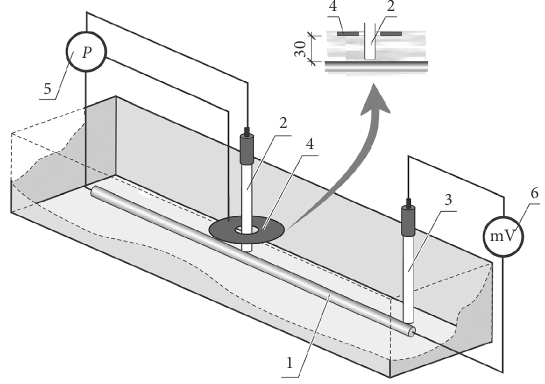
Figure 1. View of the measuring system used for the experimental determination of the electrical characteristics of the water solutions and the reinforcing bar according to (M. Jaśniok & T. Jaśniok, 2017) – description in the